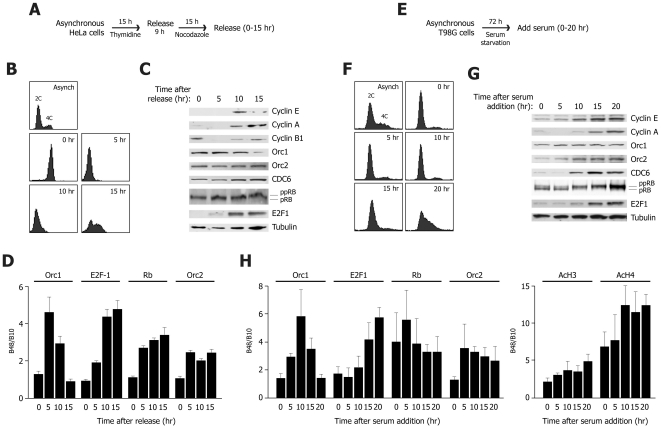
Cell cycle-dependent association of Rb and E2F1 with the Lamin B2 origin.(A) Experimental scheme for HeLa cell synchronization. HeLa cells were synchronized in mitosis by a double thymidine/nocodazole block, and then followed G1 after release from the block. (B) Flow cytometry profiles of asynchronous cells (Asynch), cells blocked in mitosis (0 hr) or cells at different times after release. (C) Western blot analysis of whole-cell extracts obtained from cells at different time points during synchronization. (D) Quantification of cross-linked lamin B2 origin DNA immunoprecipitated by ChIP. On top of the graph, the antibodies used for ChIP are shown. The histogram reports the results (mean±sem) of at least three independent experiments. The results are presented as the fold enrichment of the lamin B2 origin region (B48) over the irrelevant B10 region, after normalization for the levels of immunoprecipitated chromatin using an unrelated antibody (normal rabbit IgG) as control. (E) Experimental scheme for T98G cell synchronization. Cells were cultured without serum for 72 h and then followed for 20 h after addition of serum. (F) Flow cytometry profiles of asynchronous cells (Asynch), cells blocked in G0 by serum starvation (0 hr) or cells at different times after serum stimulation. (G) Western blot analysis of whole-cell extracts obtained from cells at different times points during synchronization. (H) Results of ChIP experiments for the lamin B2 origin, using the antibodies indicated on top of each dataset. The results are presented as in (D). AcH3: acetylated histone H3; AcH4: acetylated histone H4.